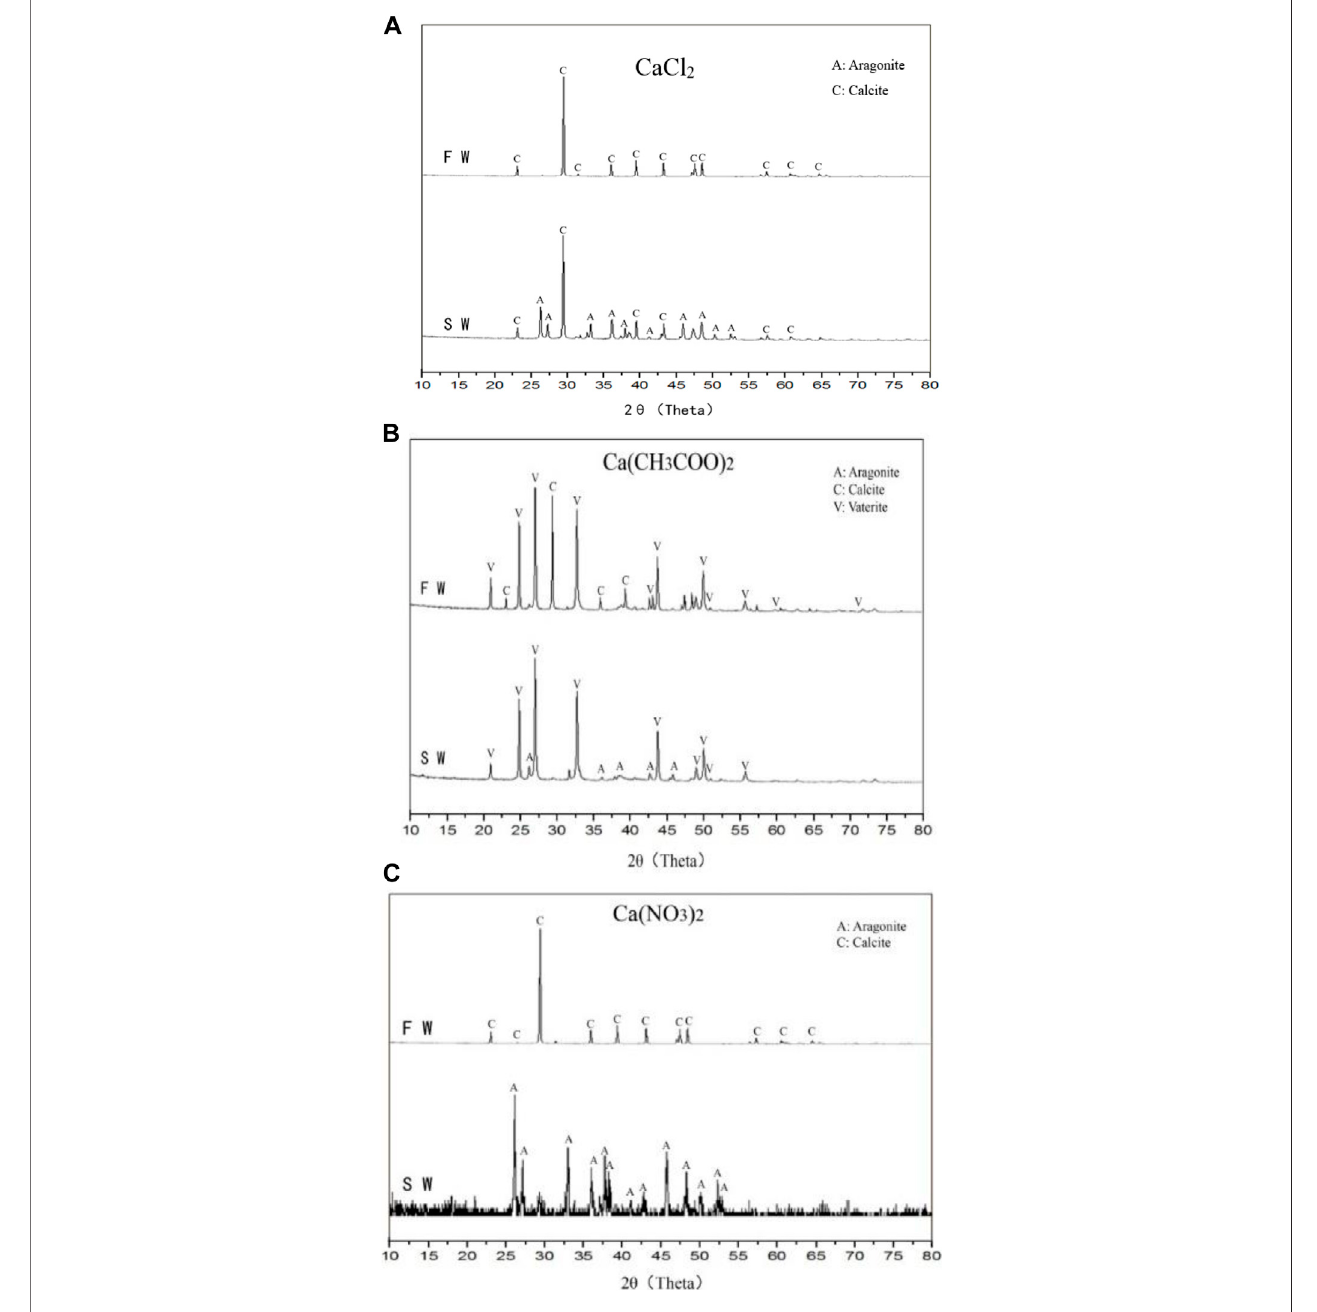
FIGURE 7 | X-ray diffraction (XRD) images of calcium carbonate crystals from different samples: (A) CaCl 2 ; (B) Ca(CH 3 COO) 2 ; (C) Ca(NO 3 ) 2 .